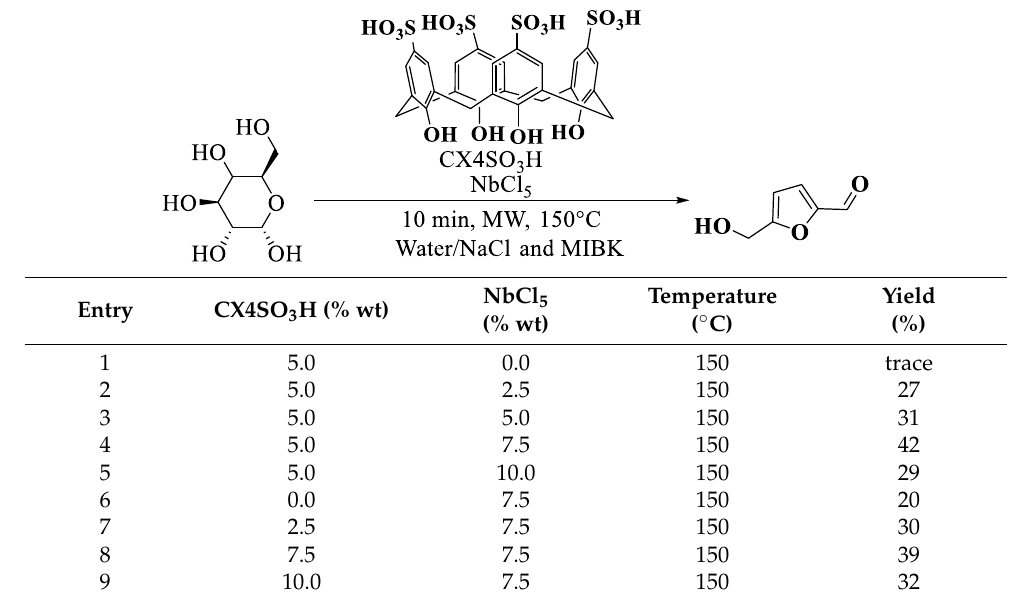
Table 1. Evaluation of ratio CX4SO 3 H/NbCl 5 consortium catalyst.